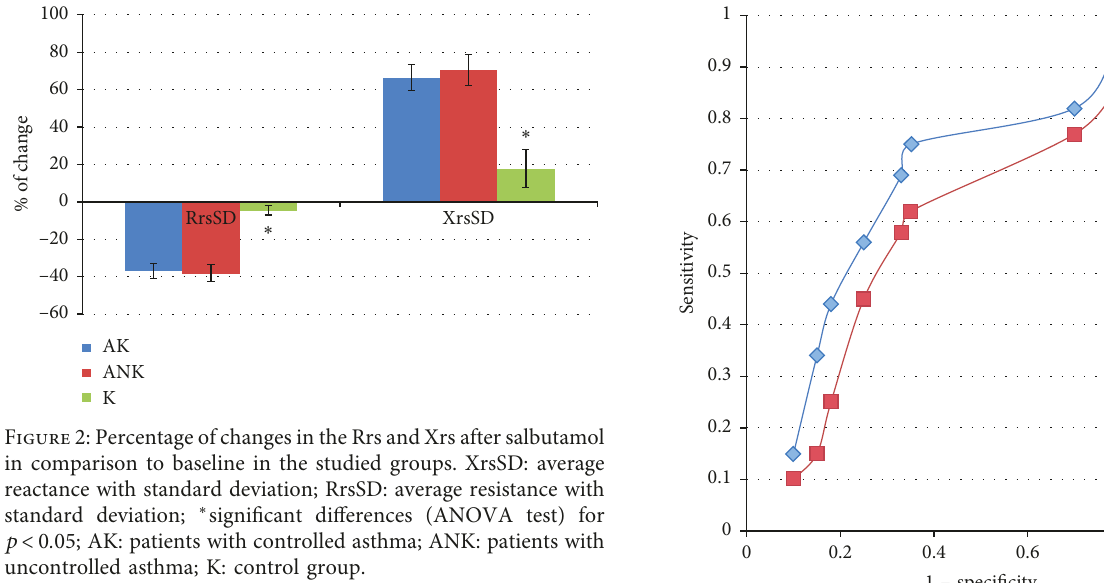
Rrs (diamonds) and Xrs (squares) for Δ Δ